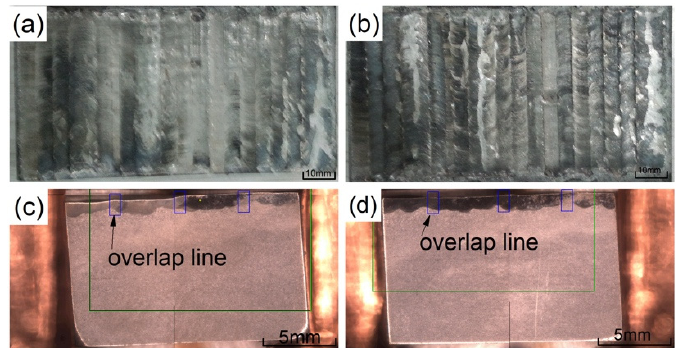
Figure 3. The macro morphology of the coatings: ( a ) 2500 W; ( b ) 2800 W; ( c ) cross section at 2500 W; ( d ) cross section at 2800 W.